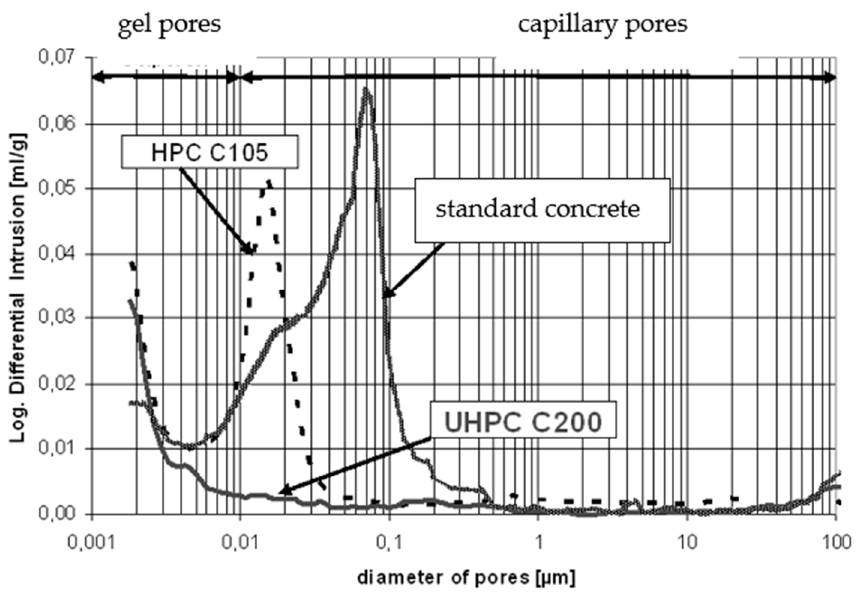
Figure 3. Pore distribution in standard concrete, high ‐ strength concrete and UHPC [30].